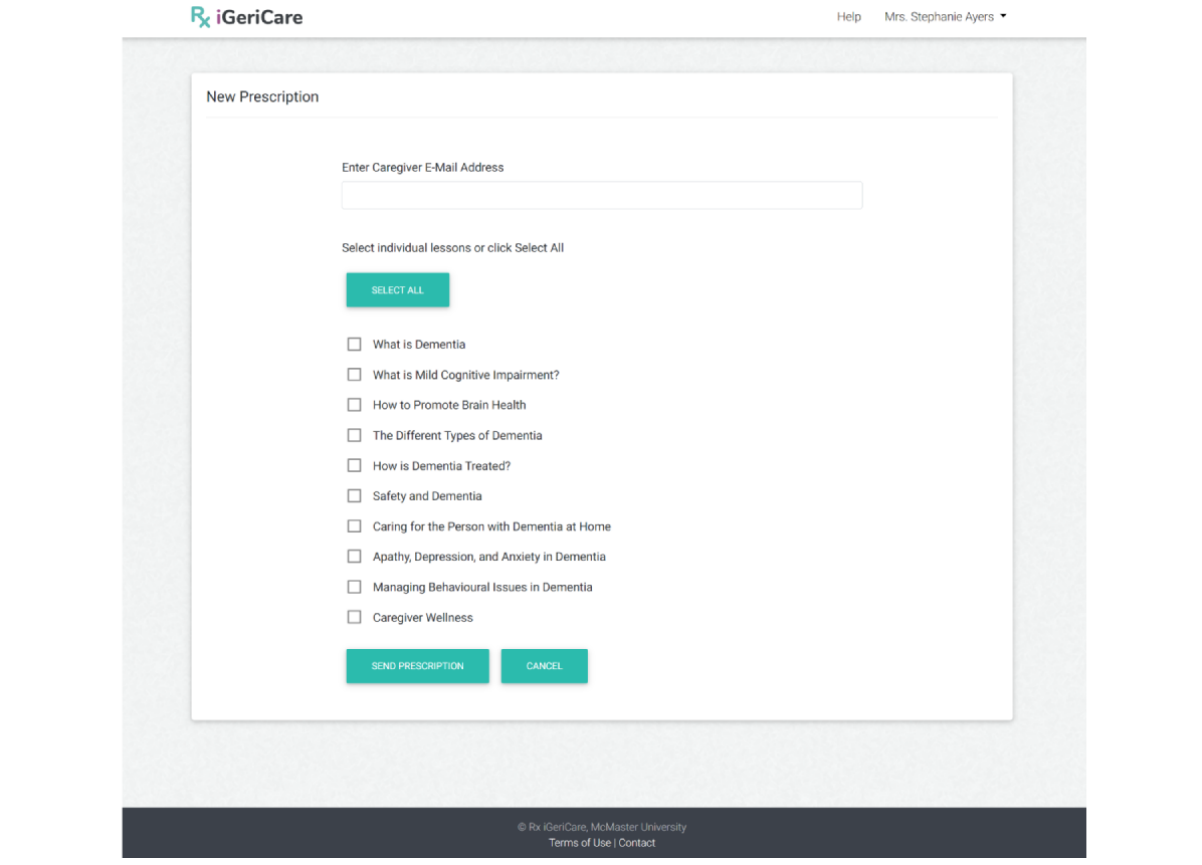
Figure 2. Education prescription application screen to create a new